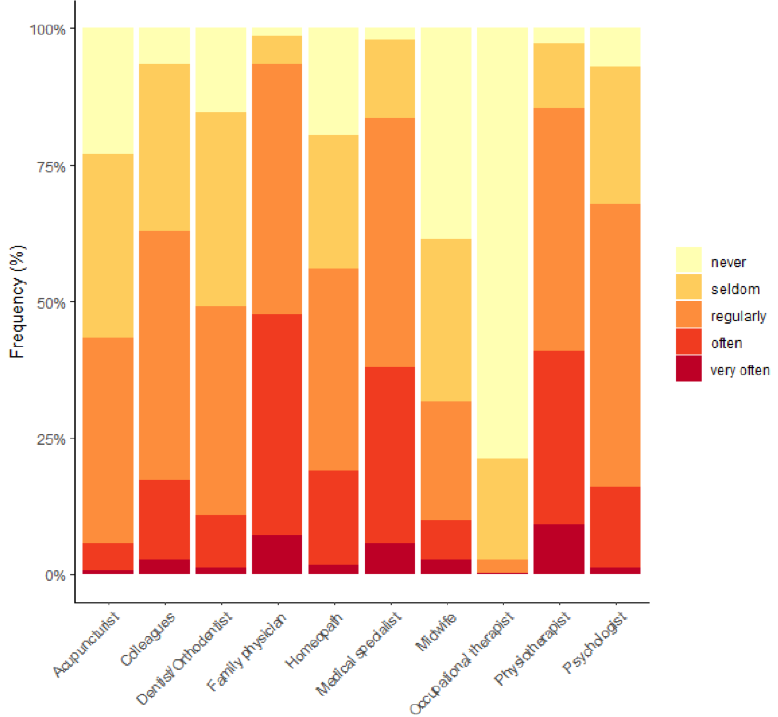
Figure 2. Frequency of referral of patients by osteopaths to other health professionals (%).